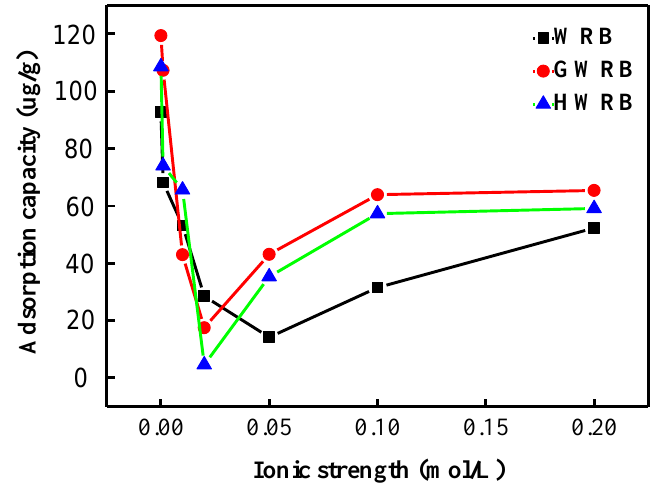
Figure 8. The e ff ect of ionic strength on the adsorption of cimetidine onto WRB, GWRB, and Figure 8. The effect of ionic strength on the adsorption of cimetidine onto WRB, GWRB, and HWRB.